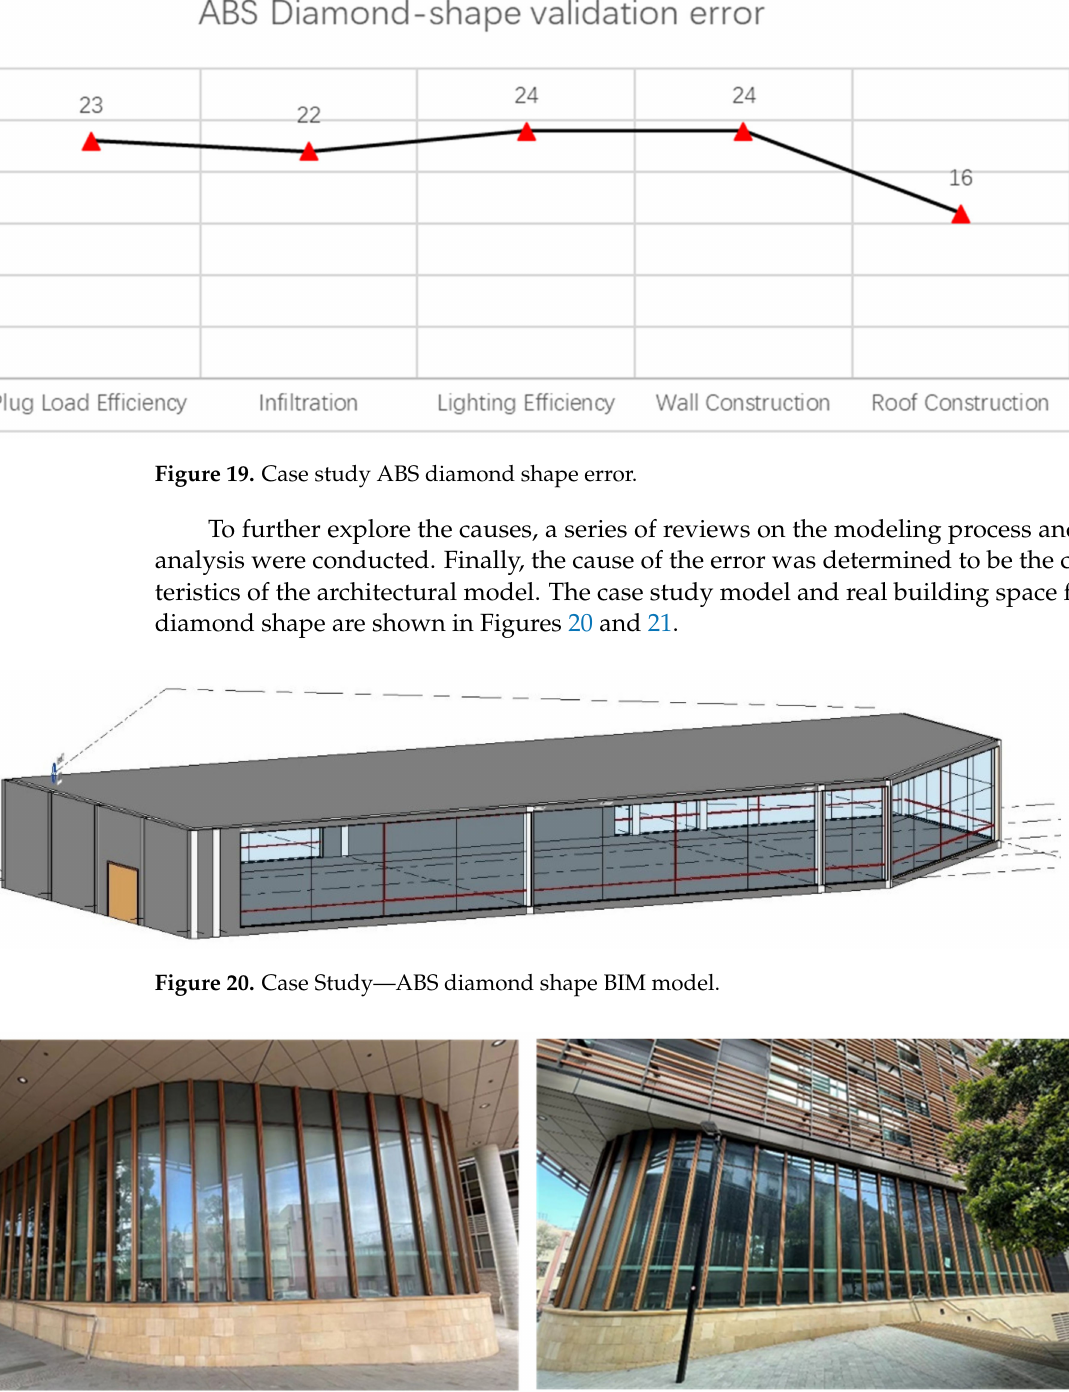
Figure 21. Case Study—Photo of ABS diamond shape, ground level, learning